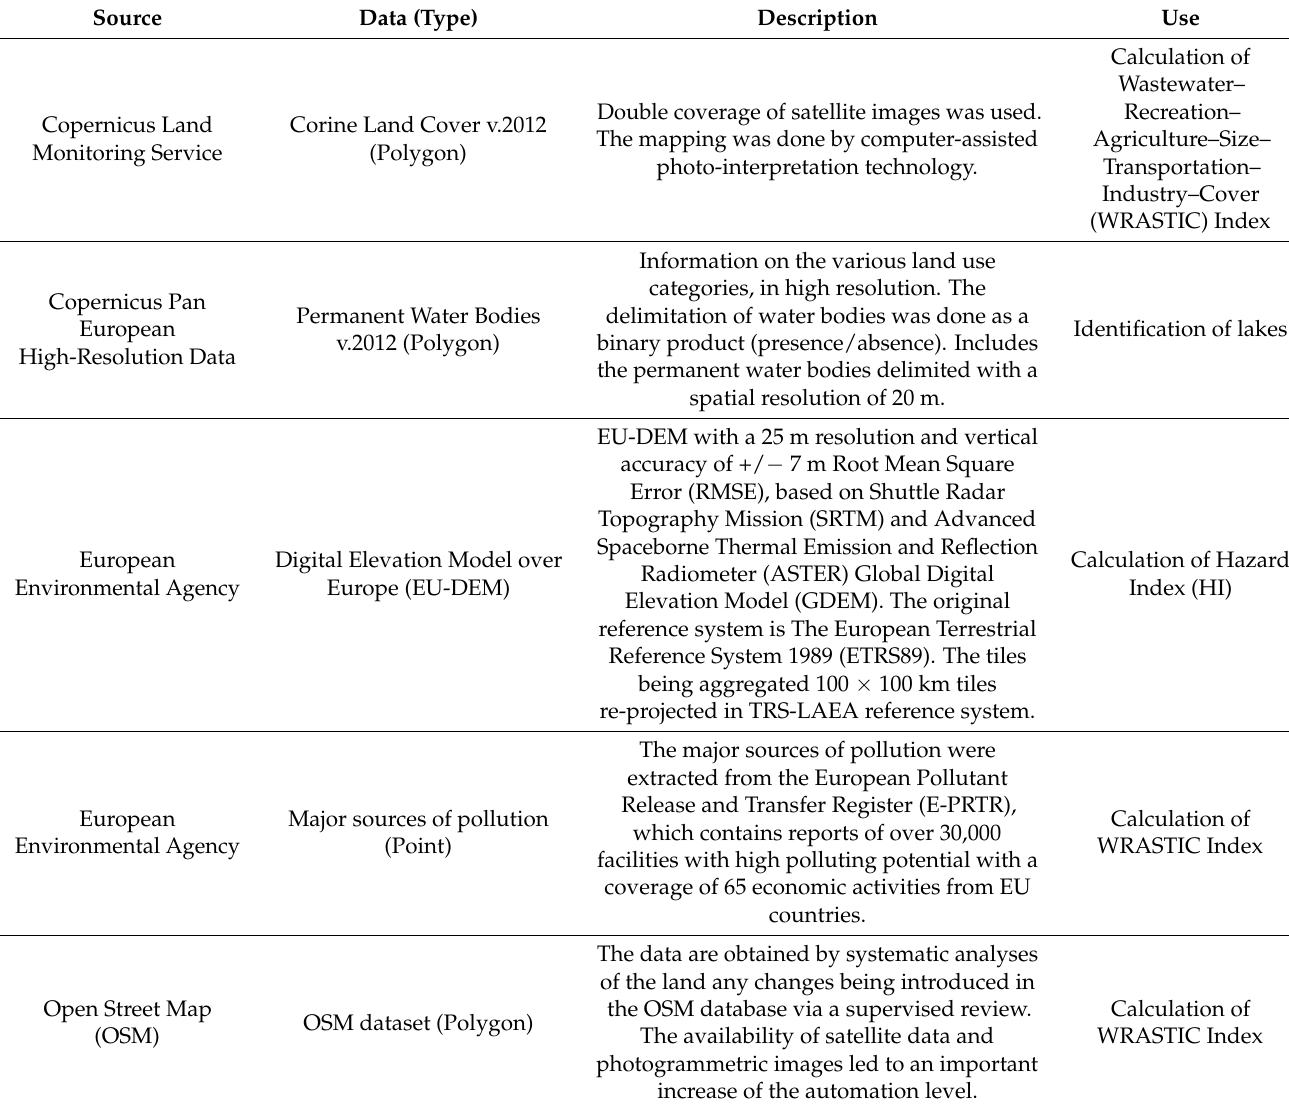
Table 1. Data sources and intermediary data